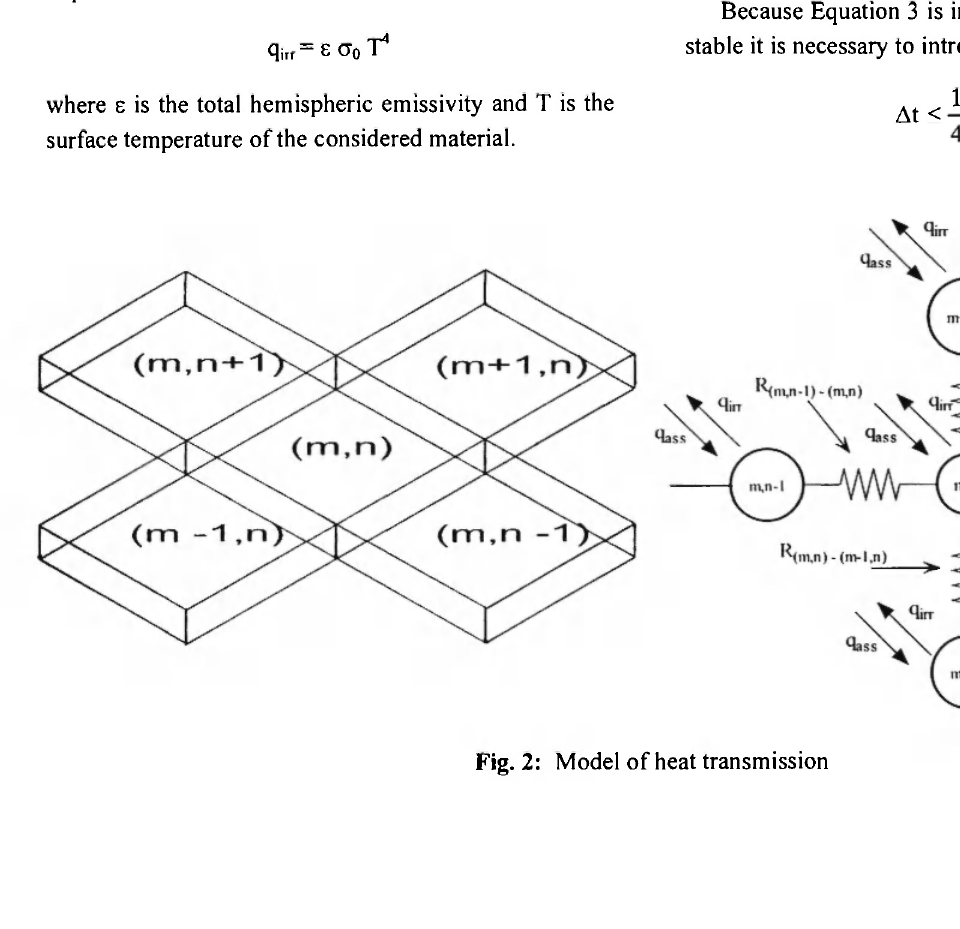
Fig. 2: Model of heat